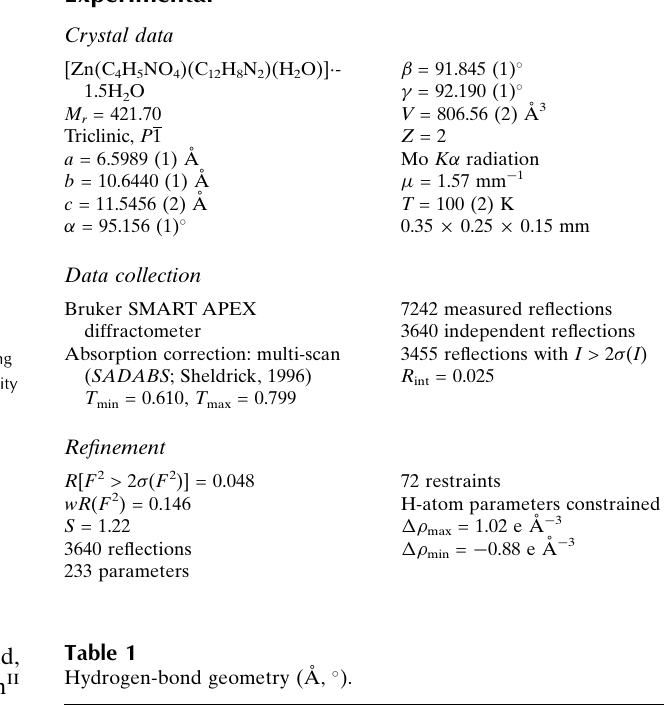
Hydrogen-bond geometry (A˚ , (cid:2)